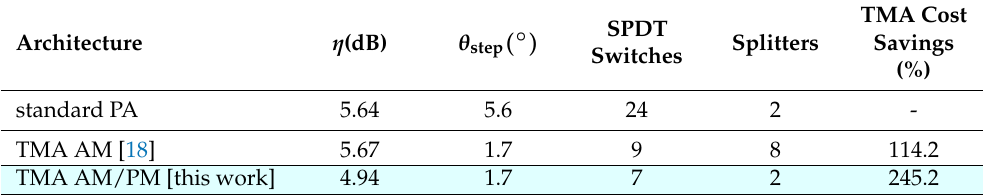
Table 4. Performance comparison –in terms of power efficiency η , phase sensitivity θ step , hardware complexity, and cost effectiveness– between the proposed dual-beam steerable TMA approach controlled with combined AM and PM waveforms (shaded in blue) and competitive solutions existing in the